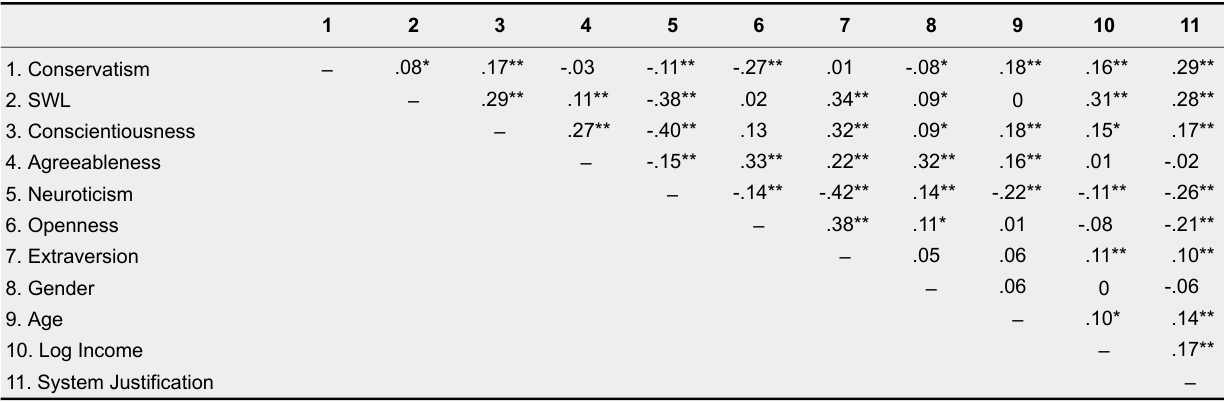
Correlation Matrix for Study 2 (N =